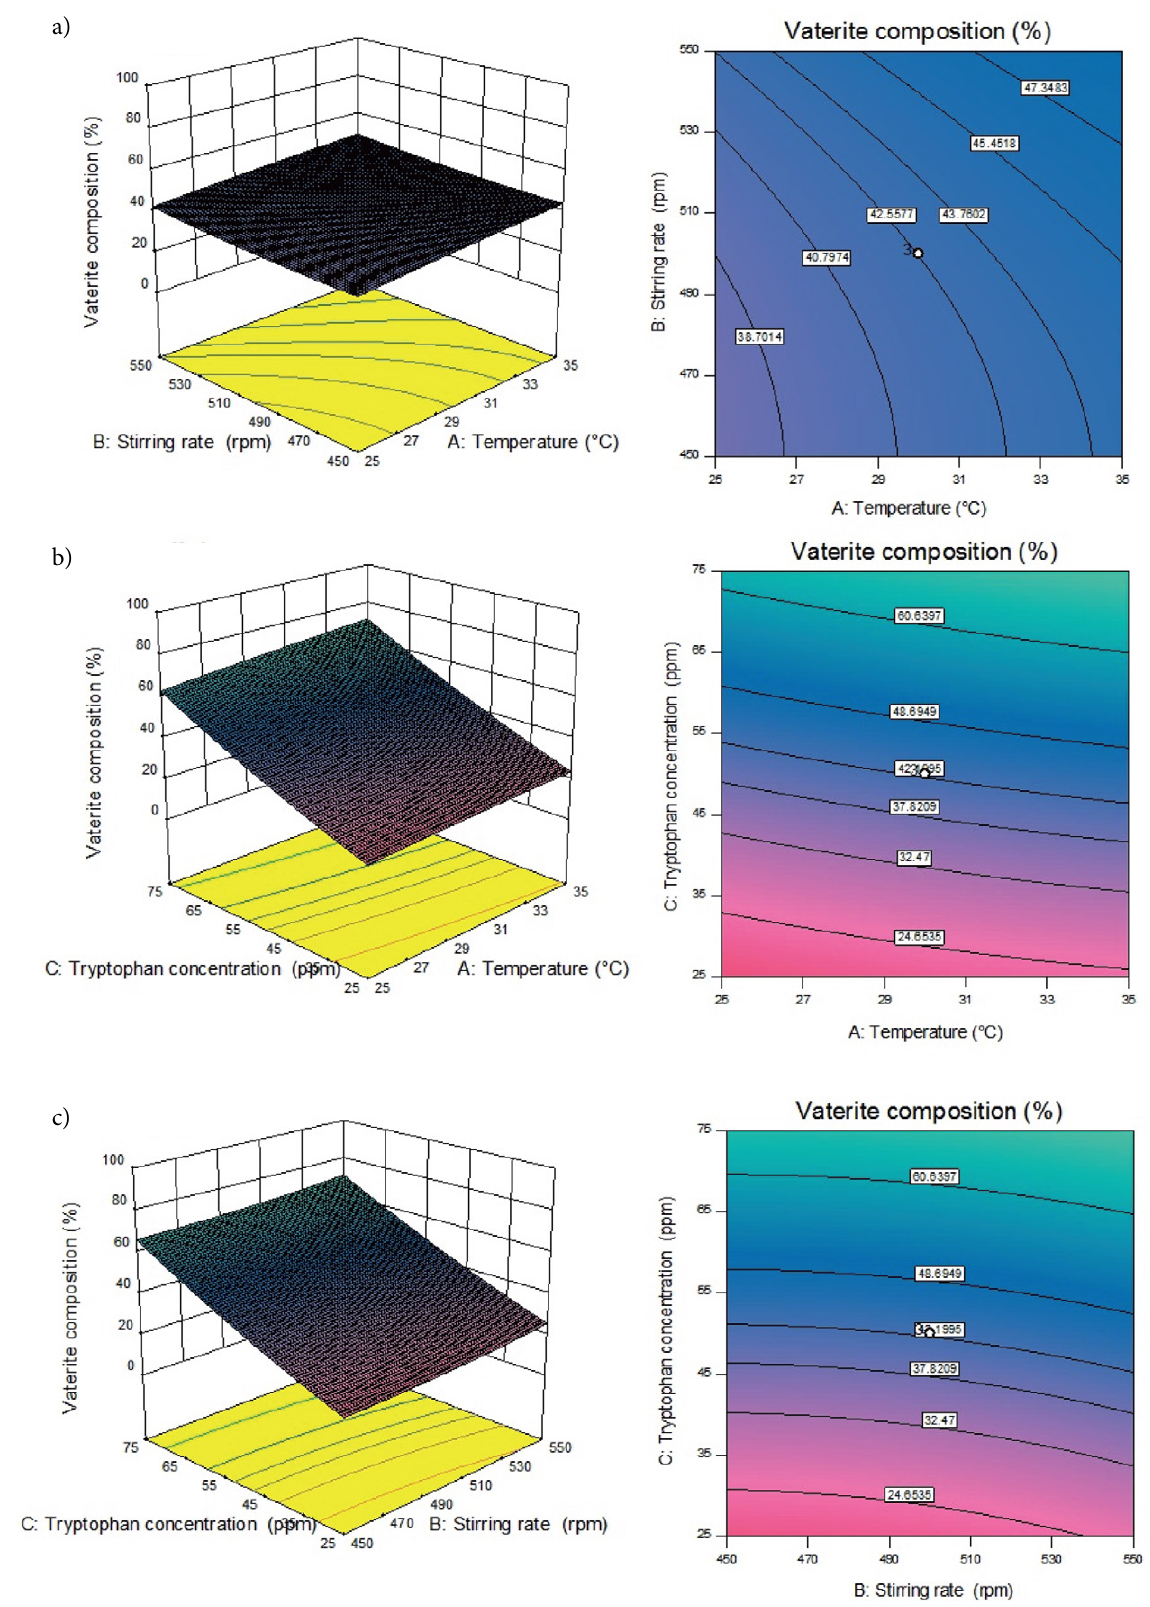
Figure 7. 3D-surface and contour plots showing the effects of (a) temperature and stirring rate; (b) temperature and tryptophan concentration; and (c) stirring rate and tryptophan concentration on the vaterite